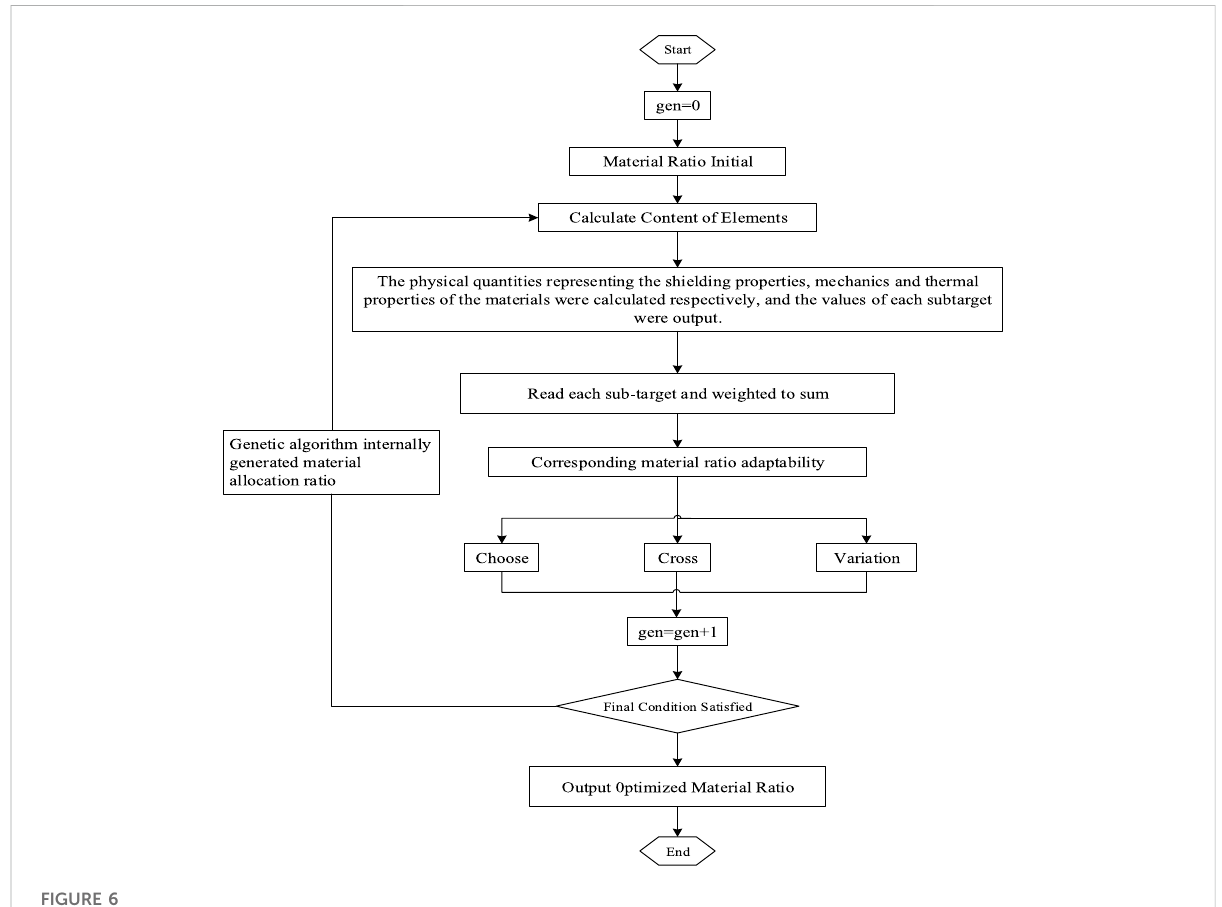
FIGURE 6 Flow chart of integrated optimization design of shielding component